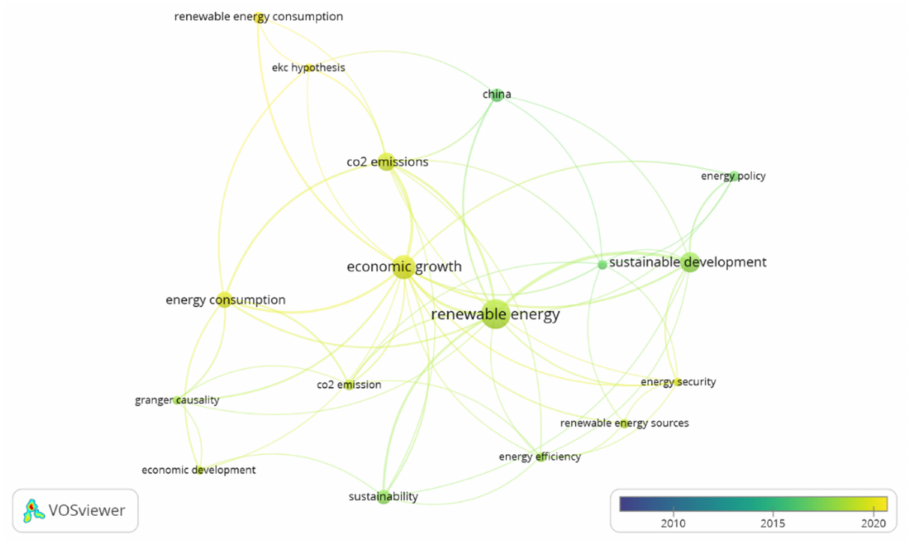
Figure 6. Keywords Overlay Visualization.